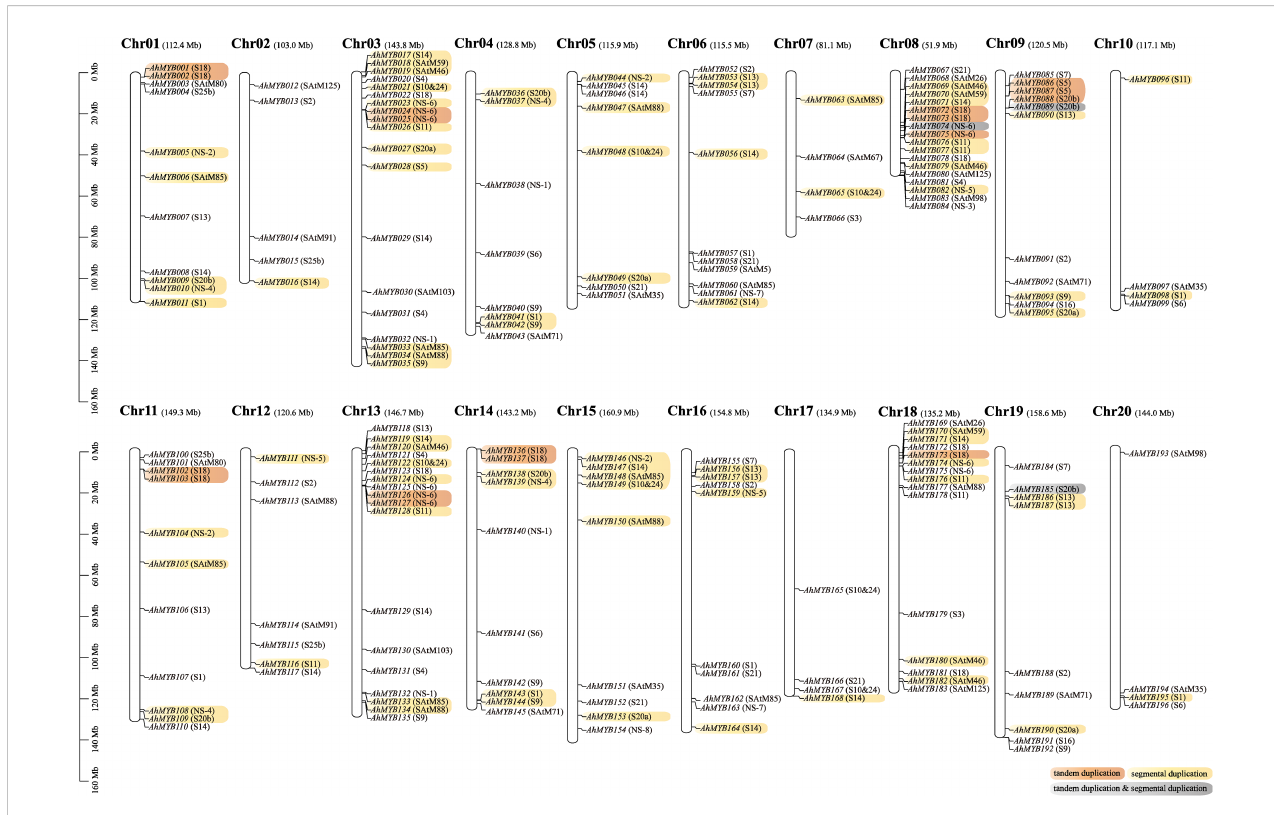
FIGURE 3 Distribution of 196 R2R3-MYB genes on 20 chromosomes. The name and length of the chromosome are displayed at the top of each chromosome. Yellow is for genes produced by segment duplication, orange is for genes from tandem duplication, and gray indicated genes that have experienced both types of duplication events. Subgroups were annotated to the right of the gene.